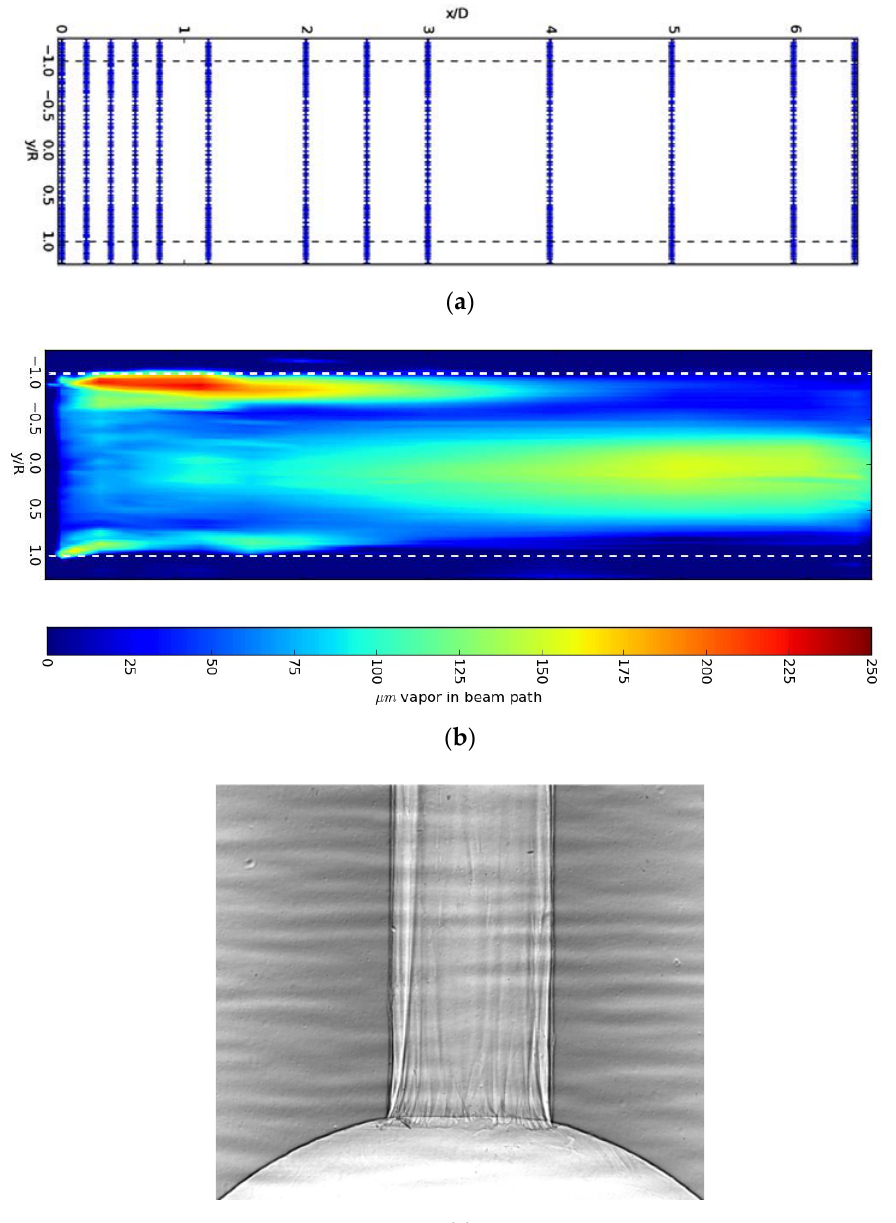
Figure 2. Experimental arrangement [15]. ( a ) The raster scan grid where X-ray radiography measurements of void were taken, ( b ) time-averaged X-ray radiography measurement of the void at CN = 11.2, ( c ) time-integrated X-ray images of nozzle inlet at CN = 11.2. (Reproduced with permission).